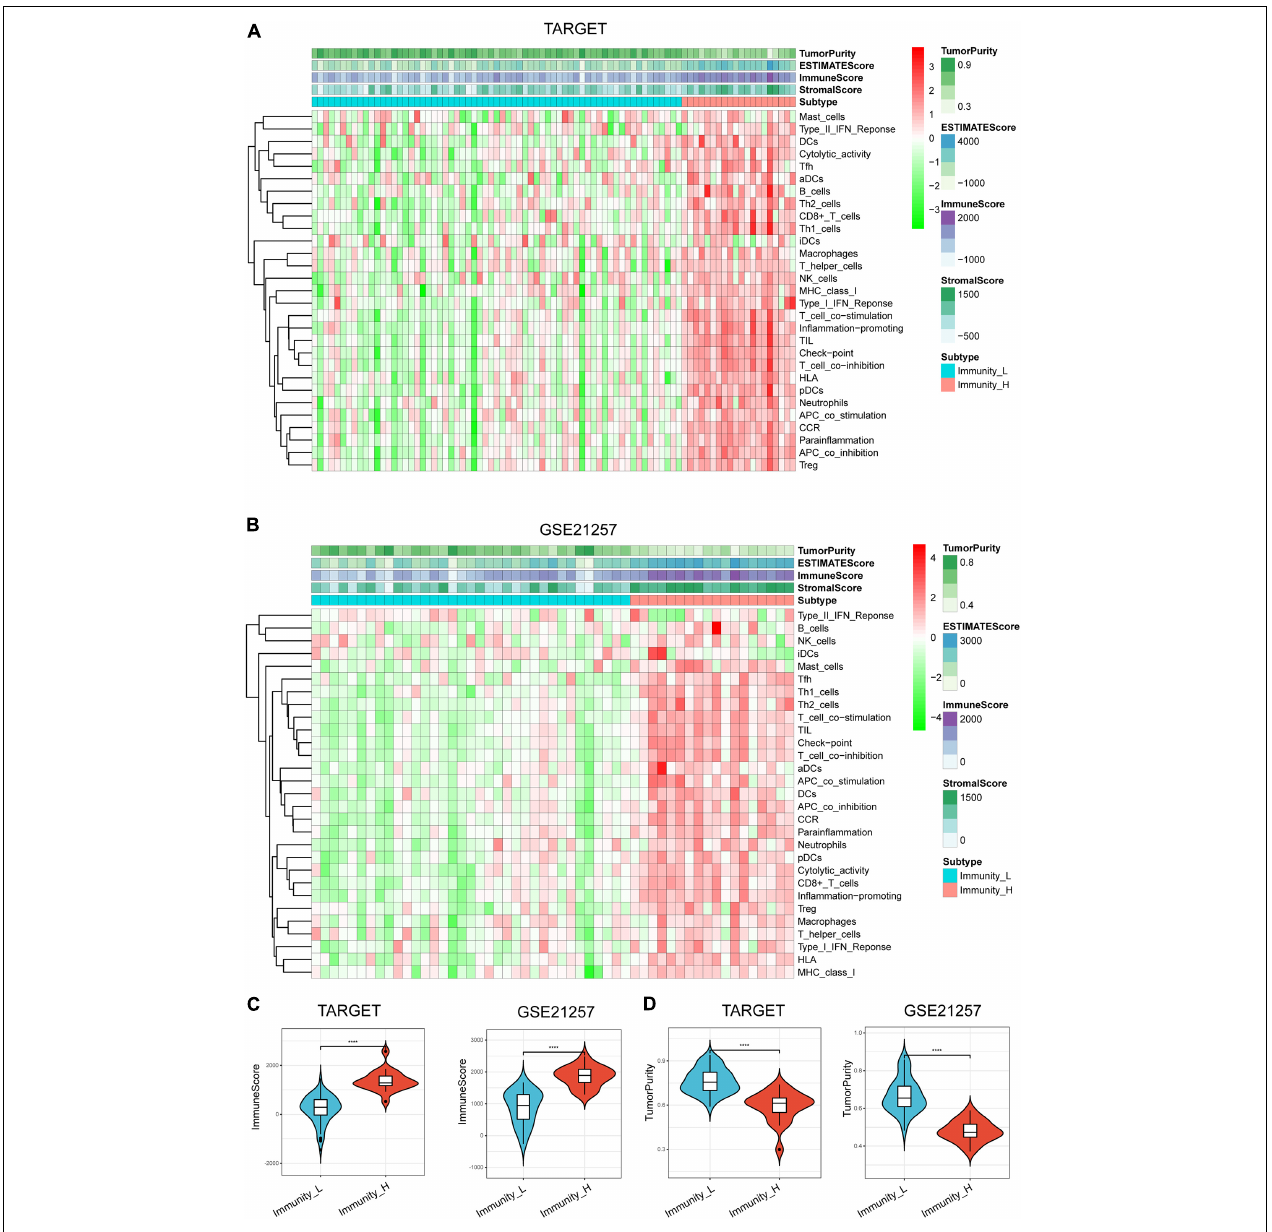
FIGURE 1 | Hierarchical clustering of osteosarcoma identified two immune subtypes in TARGET (A) and GSE21257 datasets (B) . Correlation between immunogenomic subtypes and immune cell invasion level in immune score (C) and tumor purity (D) . Violin plots particularly indicated differences in two subtypes. **** p <